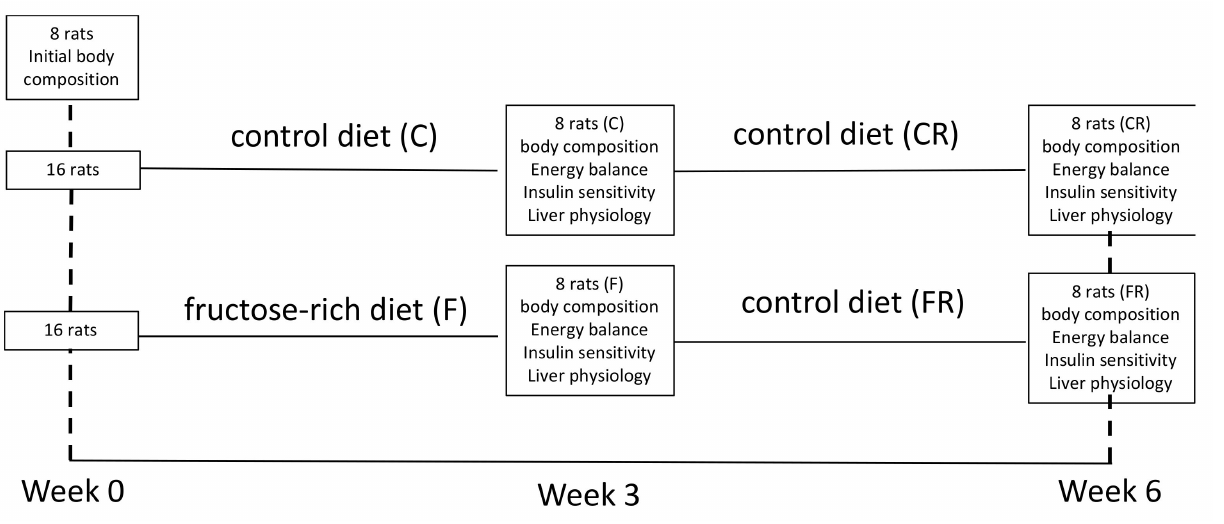
Figure 1. Experimental